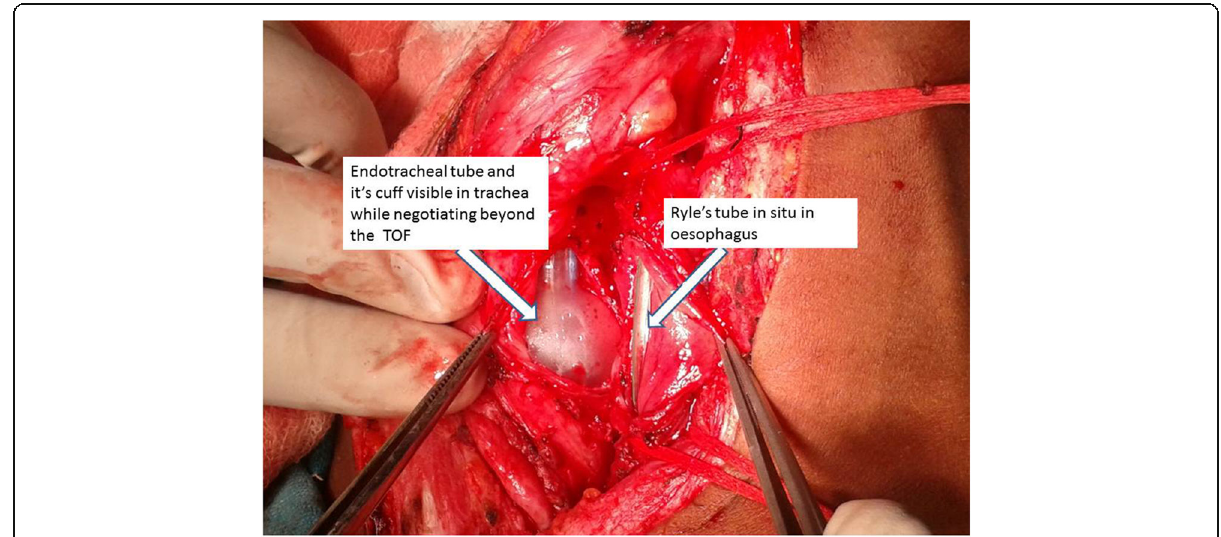
Fig. 1 Figure showing the exposed tracheal and oesophageal lumens after excision of the TOF. The tracheal lumen shows the endotracheal tube and its cuff as it is being passed beyond the TOF. The oesophageal lumen shows Ryle ’ s tube in